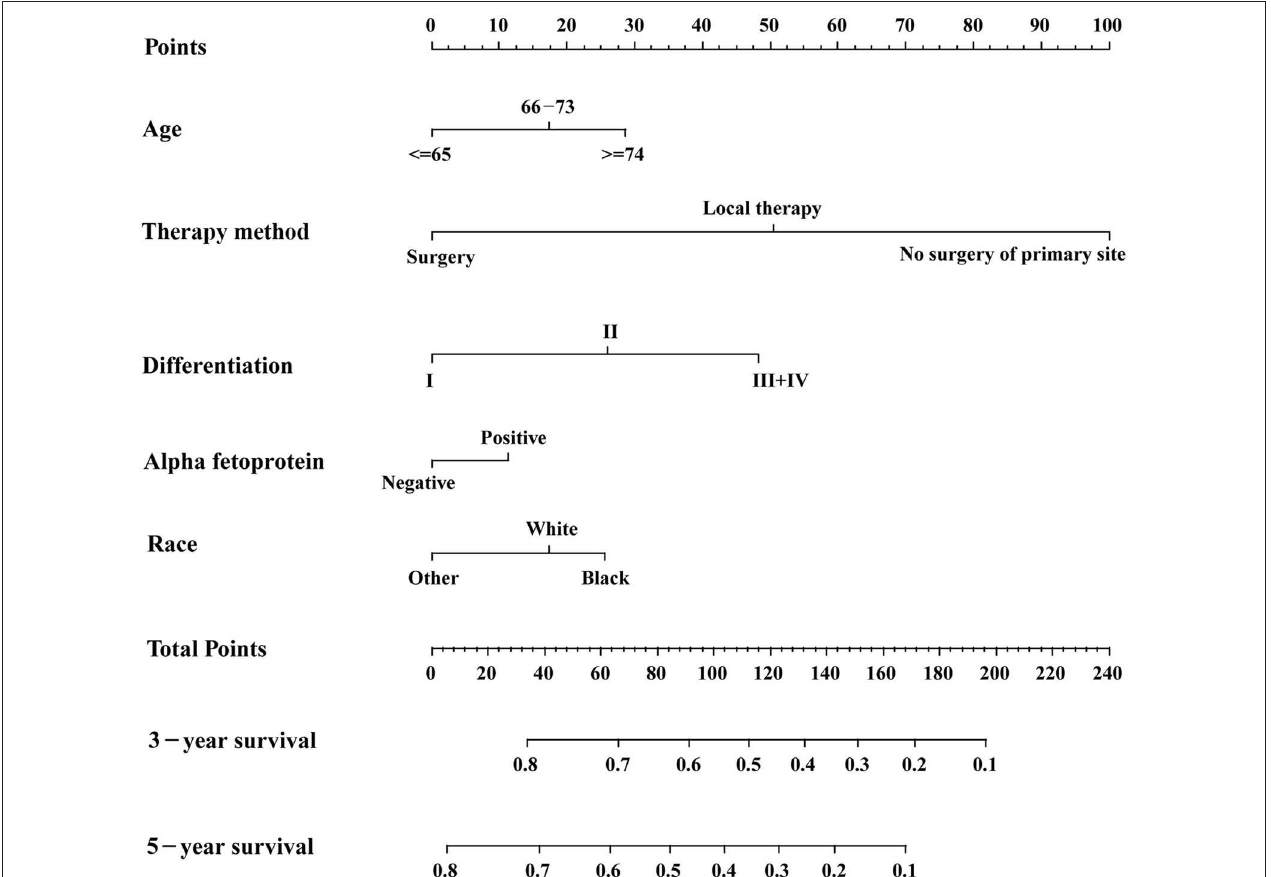
FIGURE 2 | The nomogram for predicting 3- and 5-year survival probabilities of patients with early hepatocellular carcinoma.